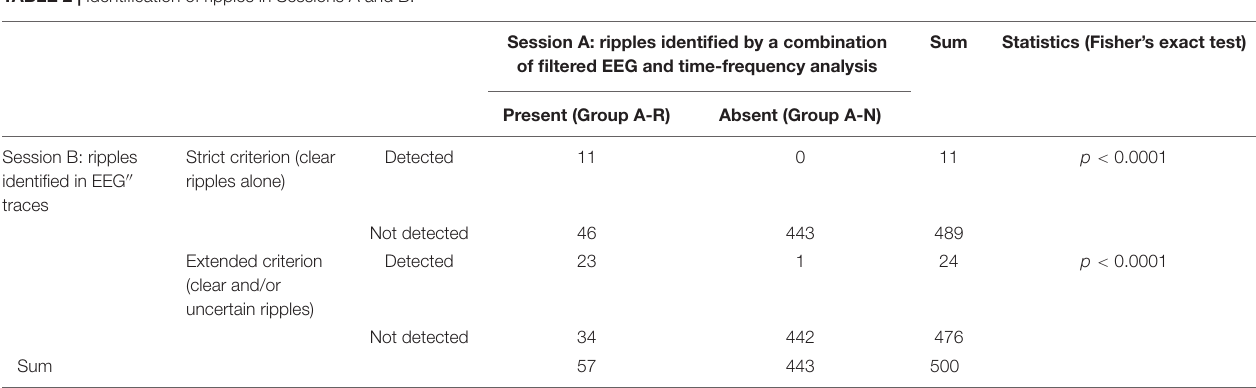
TABLE 2 | Identification of ripples in Sessions A and